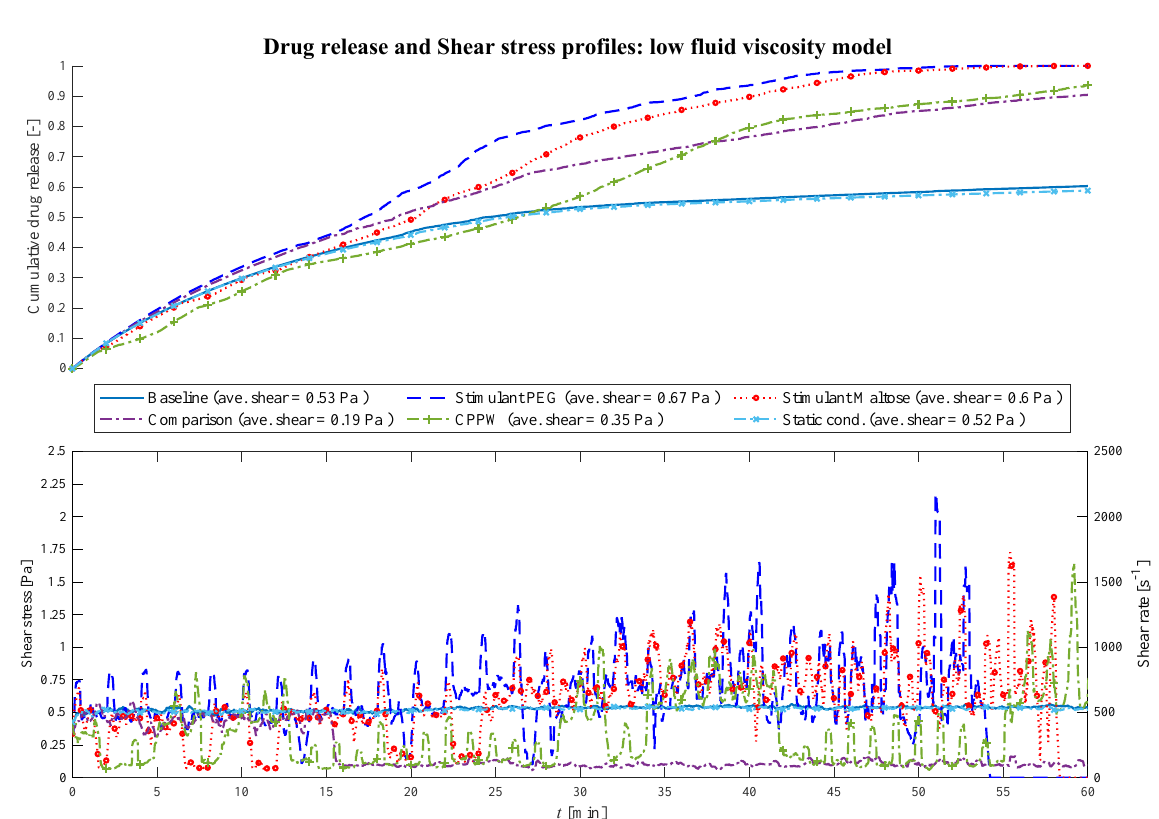
Figure 7. Comparison of the drug release profile of the different models at low fluid viscosity conditions as well as the comparison of the shear stress/shear rate acting on the tablet.